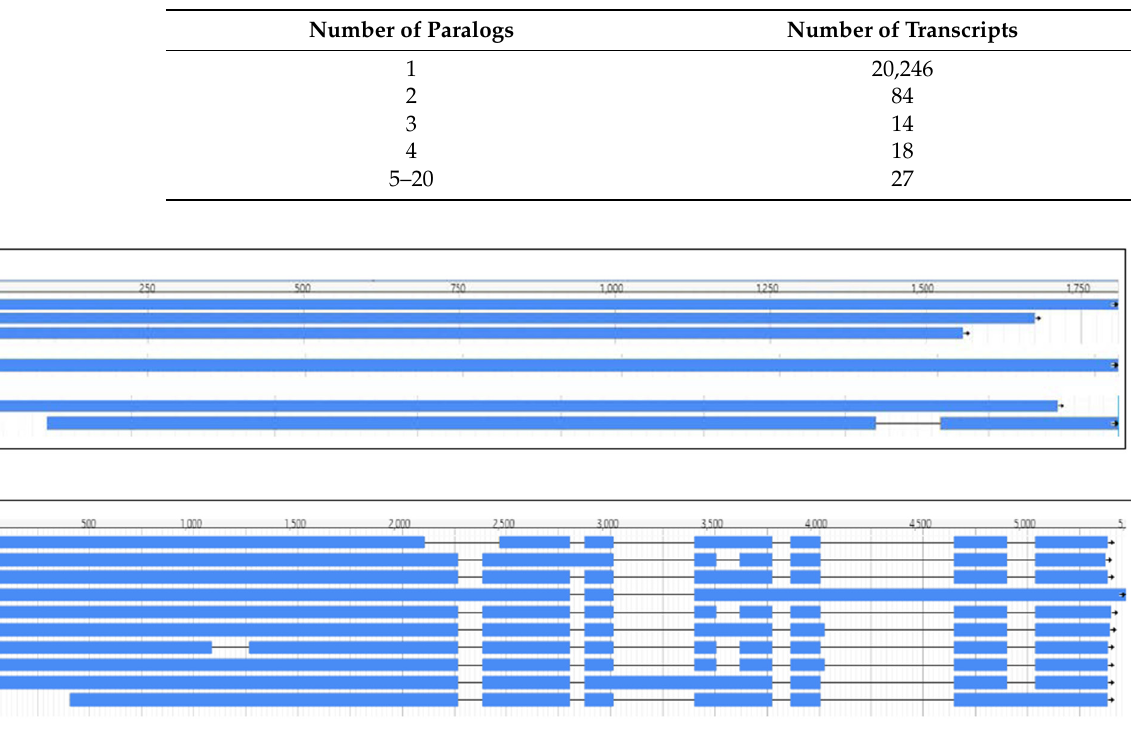
Figure 3. Paralogs and isoforms. ( A ): DOXP had three paralogs: DOXP.para1, DOXP.para2, and DOXP.para3. DOXP.para1 had three isoforms with different translation termination sites. DOXP.para3 had two isoforms due to alternative splicing and differences in translation initiation and termination sites. ( B ): PB84.1 is a tRNA ligase gene. It had no paralogs, but 10 isoforms, which differed by alternative splicing and different translation initiation and termination